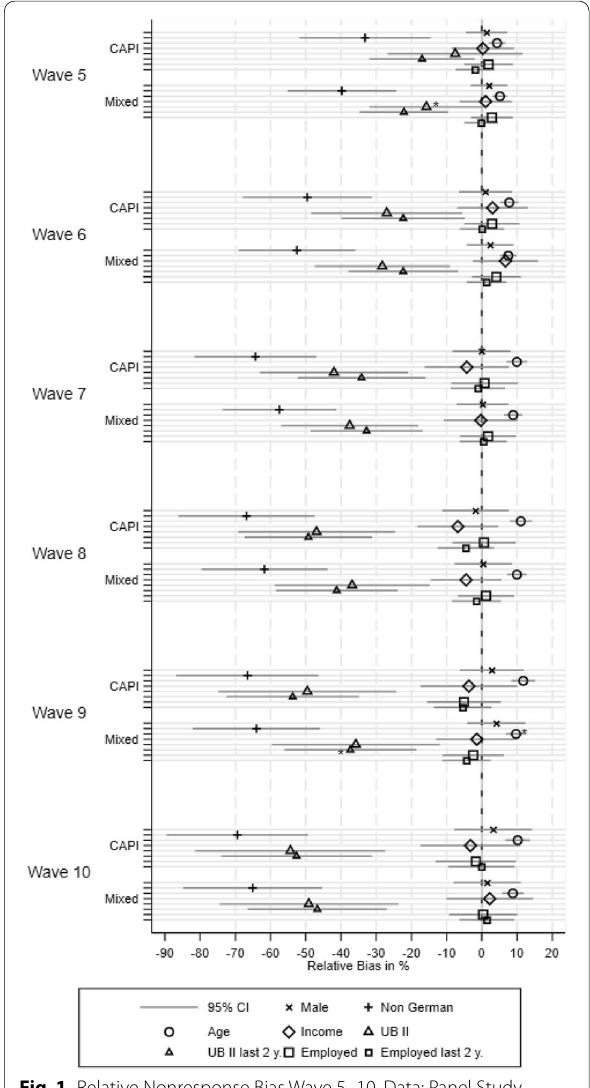
Fig. 1 Relative Nonresponse Bias Wave 5–10. Data: Panel Study Labour Market and Social Security (PASS) PASS_0618_v1, sample 6 Waves 5–10 & PASS paradata, Waves 5–10 & IAB Integrierte Erwerbsbiografien (IEB) V13.00.00. * Difference between CAPI and = mixed-mode within a wave is statistically significant at 5%